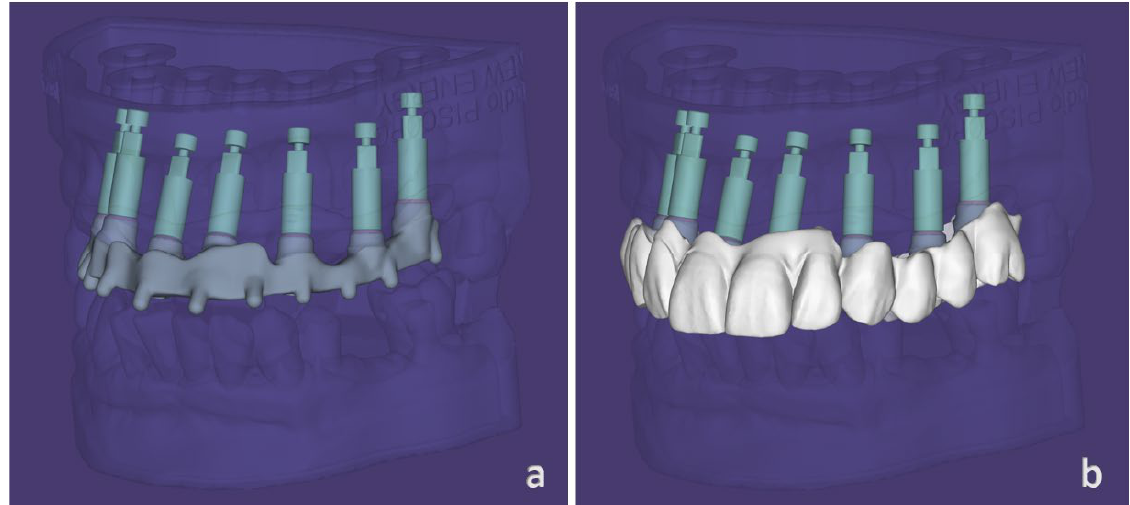
Figure 7. Computer-aided design framework ( a ) and final prosthetic volumes ( b ).